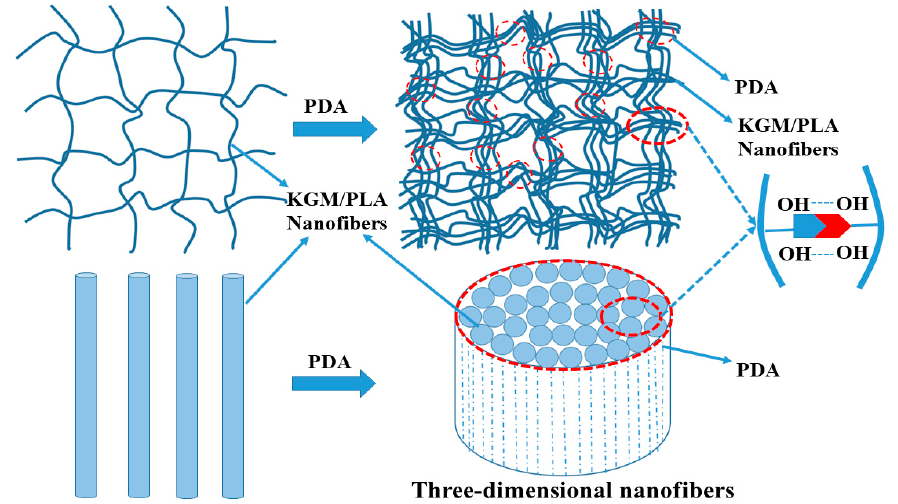
Scheme 1. The mechanism diagram and hydrogen-bond interaction (red dotted circle) of KGM/PLA nanofibers and PDA.